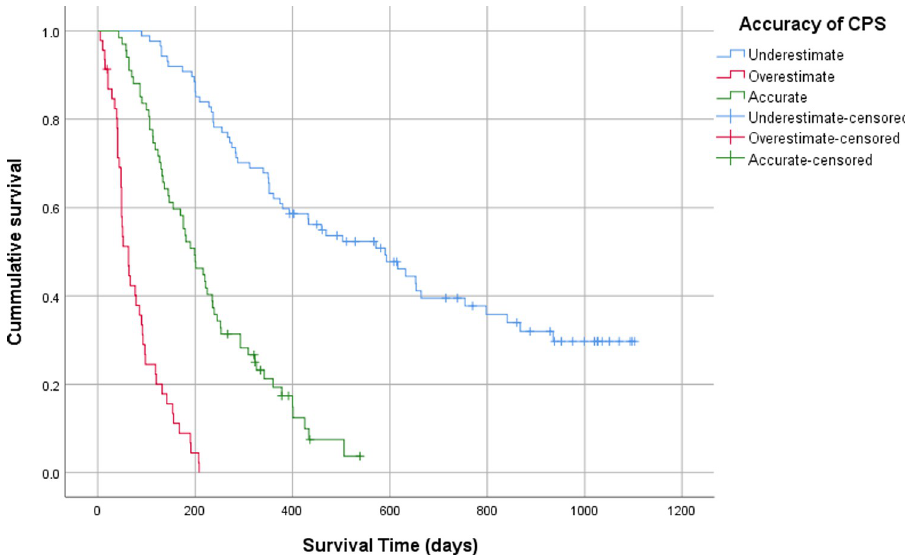
Fig 2. Survival according to the accuracy of clinician prediction of survival. Patients with accurate clinician prediction of survival (CPS), underestimated CPS, and overestimated CPS had median survival times of 6.6 months (95% CI 5.1–8.2), 19.7 months (95% CI 13.6–25.8), and 2.1 months (95% CI 1.5–2.7), respectively. The differences in survival in the three groups were all significant (accurate CPS vs. underestimated CPS: P < 0.001; accurate CPS vs. overestimated CPS: P < 0.001) by the log-rank